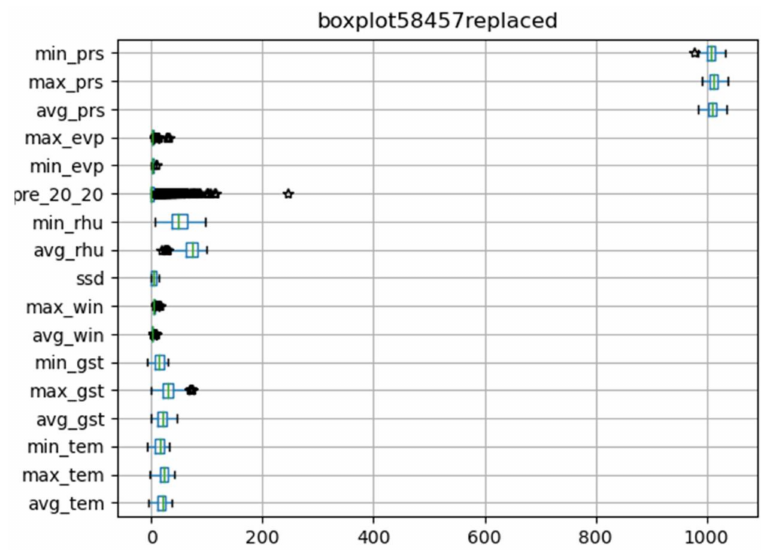
Figure 3. Illustration of the meteorological data after cleaning for abnormal values.